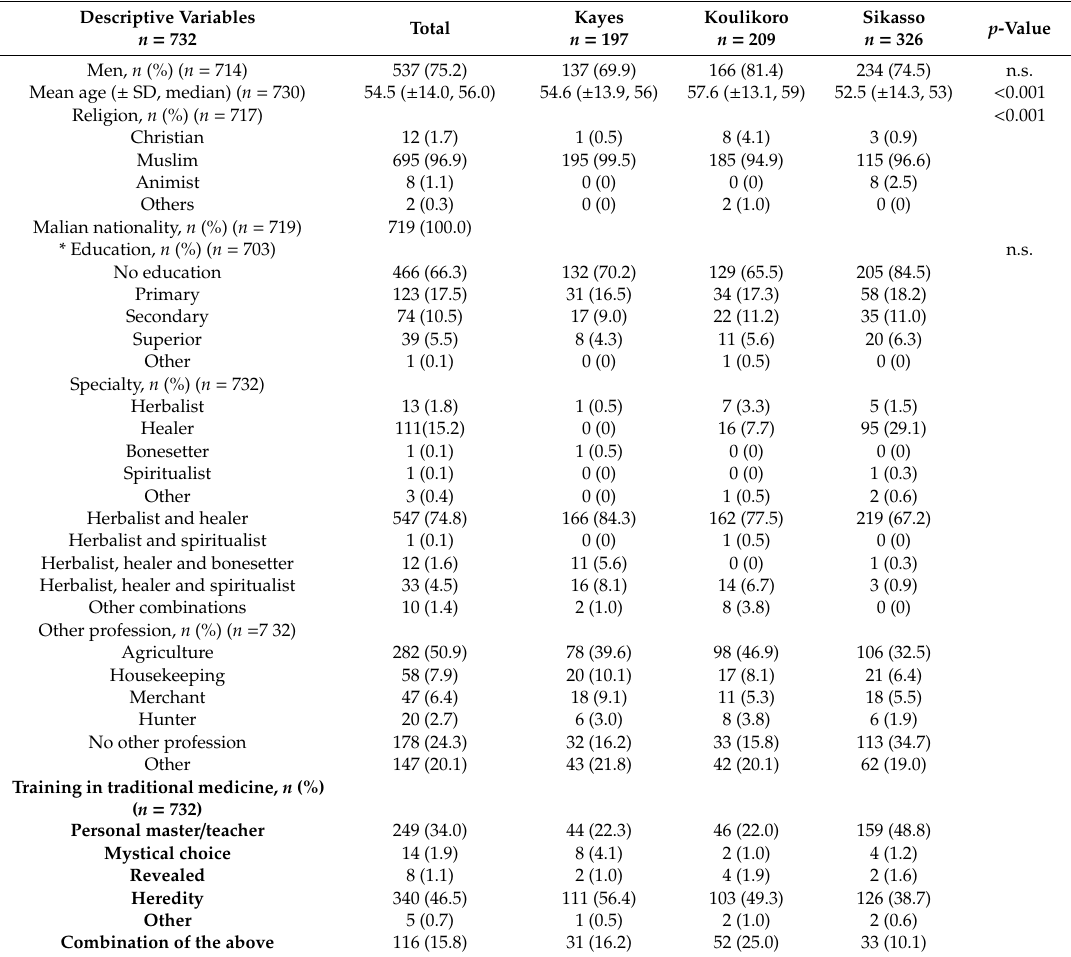
Table 1. Sociodemographic